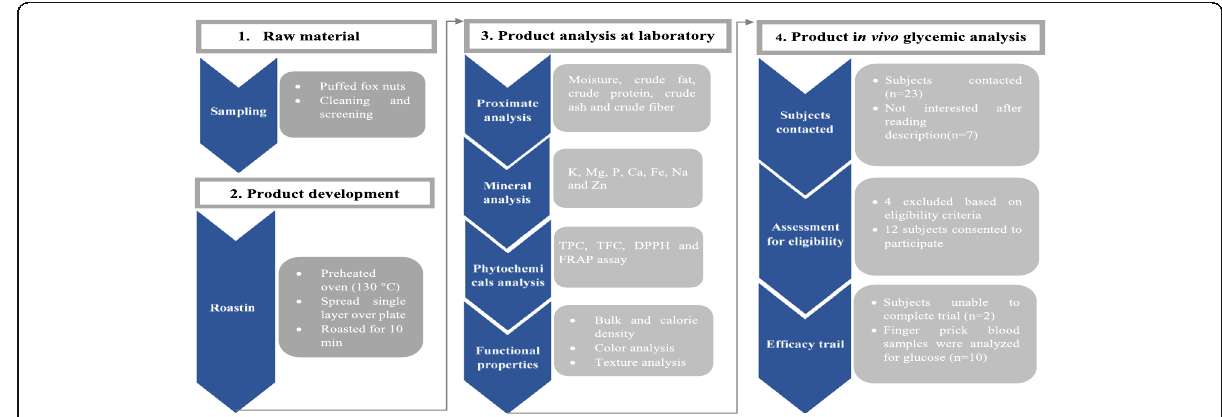
Fig. 1 Flow chart of study design showing all the major steps of